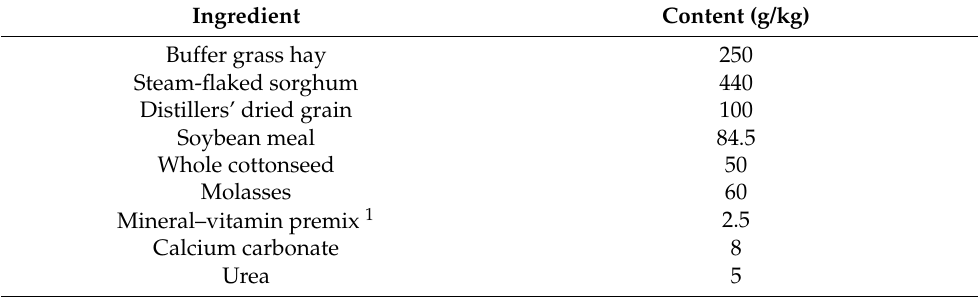
Table 1. Heifers’ reception diet (as fed). Ingredient Content (g/kg) Buffer grass hay 250 Steam-flaked sorghum 440 Distillers’ dried